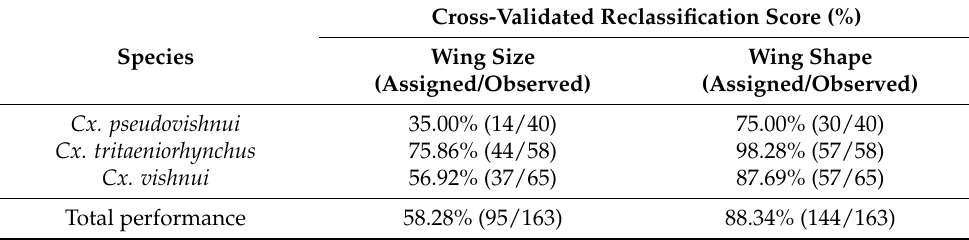
Table 3. Cross-validation reclassification score (%) based on wing size (centroid size) and wing shape (Mahalanobis distance values) of the Cx. vishnui subgroup.